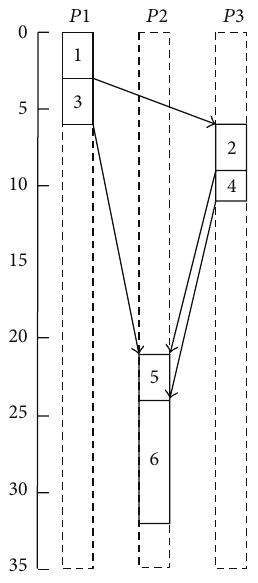
Figure 8: Realistic view of schedule by HEFT.